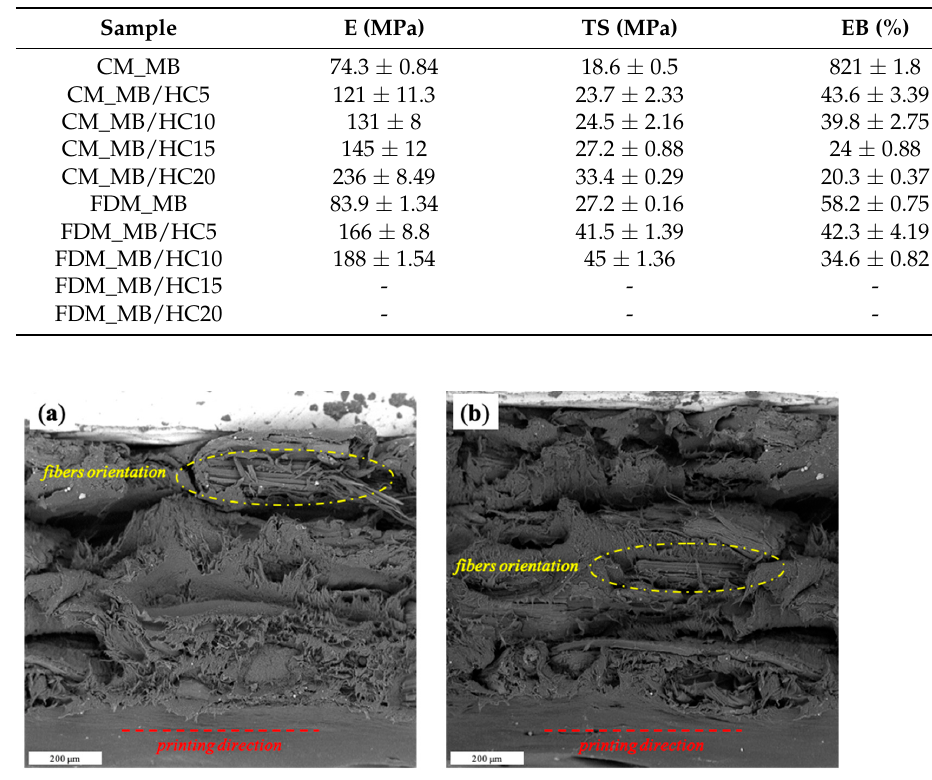
Figure 5. SEM micrograph of fractured cross-sections of FDM_MB/HC5 ( a ); FDM_MB/HC10 ( b ).